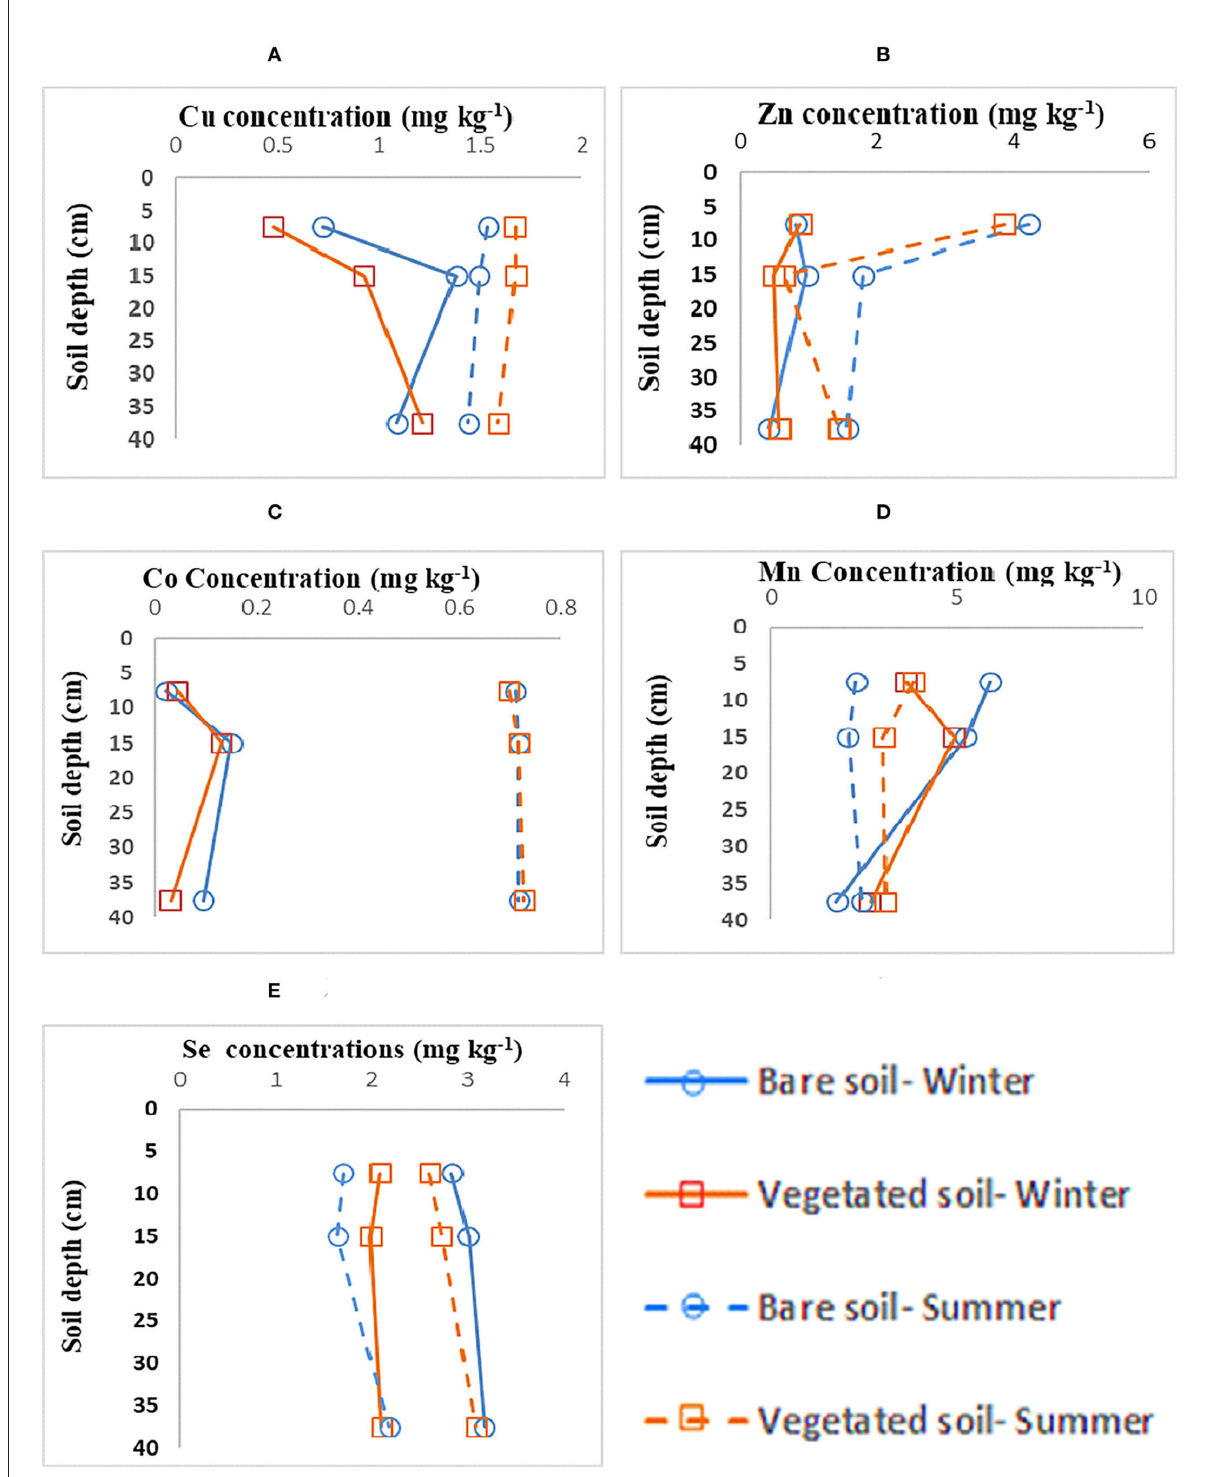
FIGURE2 (A–E) Metal depth profiles in Shadegan wetland hydric coastal soils over two seasons, three depth intervals, and two vegetation cover